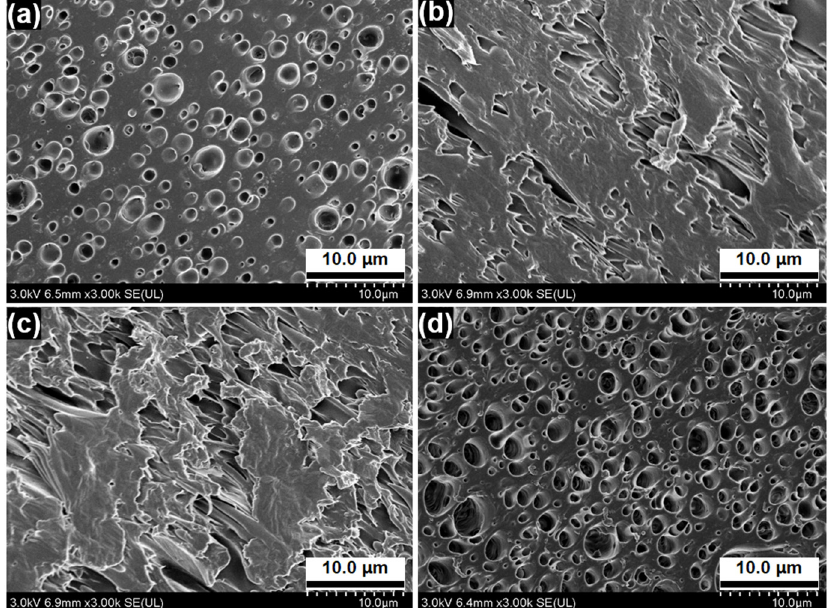
Figure 5. SEM image of TPU/PLA blends with PLA removed: ( a ) 80/20, ( b ) 60/40, ( c ) 40/60, and ( d ) 20/80.